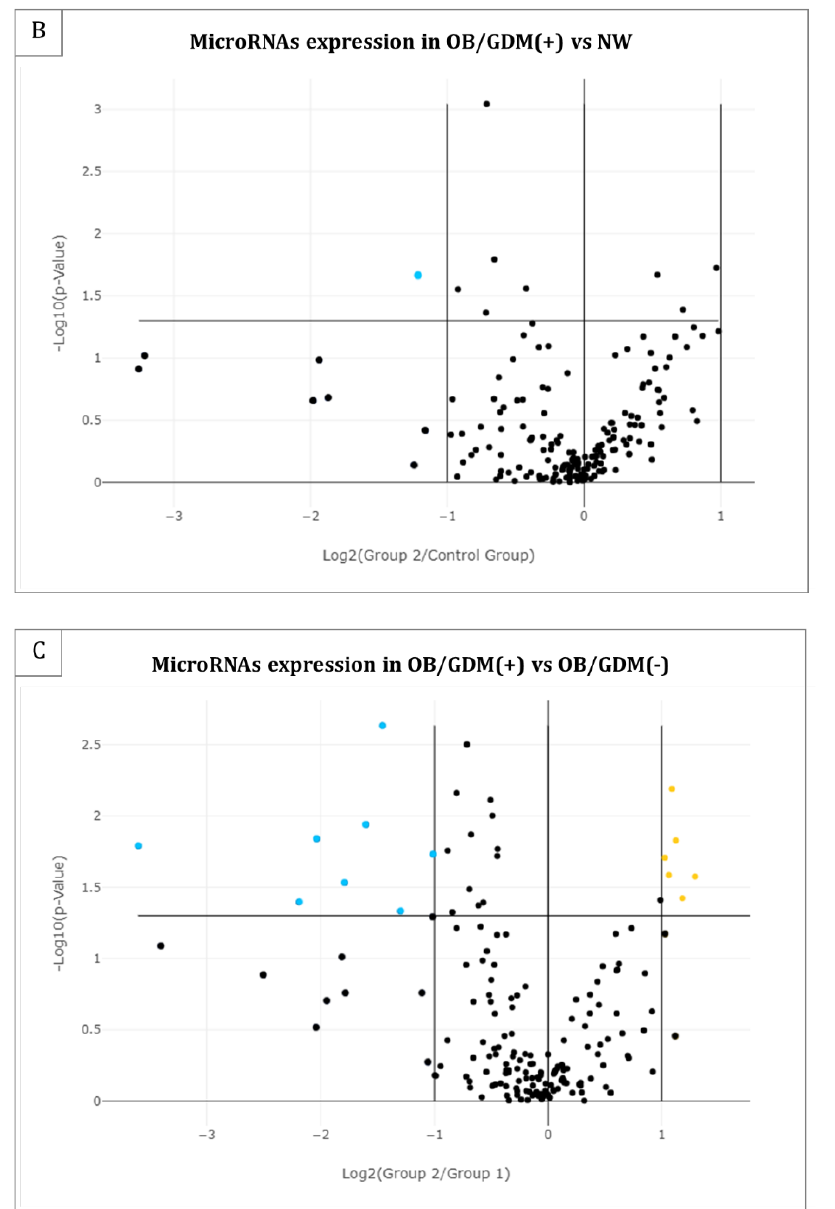
Figure 1. Volcano Plots of the 179 analysed microRNAs in maternal plasma for the following comparisons: ( A ) OB/GDM(−) vs. NW, ( B ) OB/GDM(+) vs. NW, and ( C ) OB/GDM(+) vs. OB/GDM(−). Significant miRNA expression changes for each group comparison are presented by plotting the log2 of the Fold Changes in miRNA expression on the x-axis versus their statistical significance on the y-axis. The two vertical lines represent Fold Regulation cut-off of |2|, while the horizontal line indicates the statistical significance ( p -value) of 0.05. MiRNAs in the far upper left (downregulated: blue points) and far upper right (upregulated: yellow points) sections meet the selected fold regulation and p -value thresholds; the black points identify all the miRNAs which do not comply with these criteria. Data and graph obtained by GeneGlobe (Qiagen).